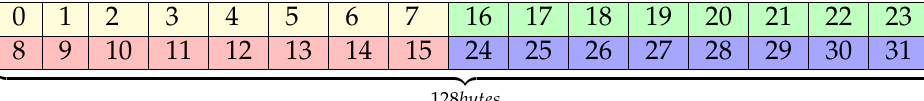
Figure 13. Data reading order from shared memory to registers with LDS.64 instructions.